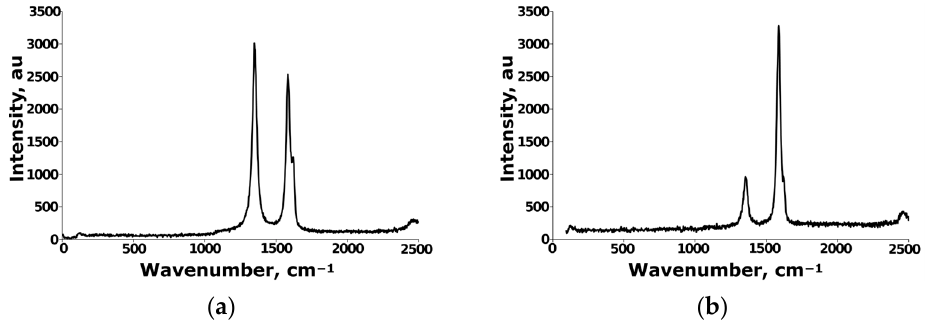
Figure 3. Raman spectra of acid treated and rinsed samples after mild oxidation before ( a ) and after ( b ) heat treatment at 480 °C for 6 h.